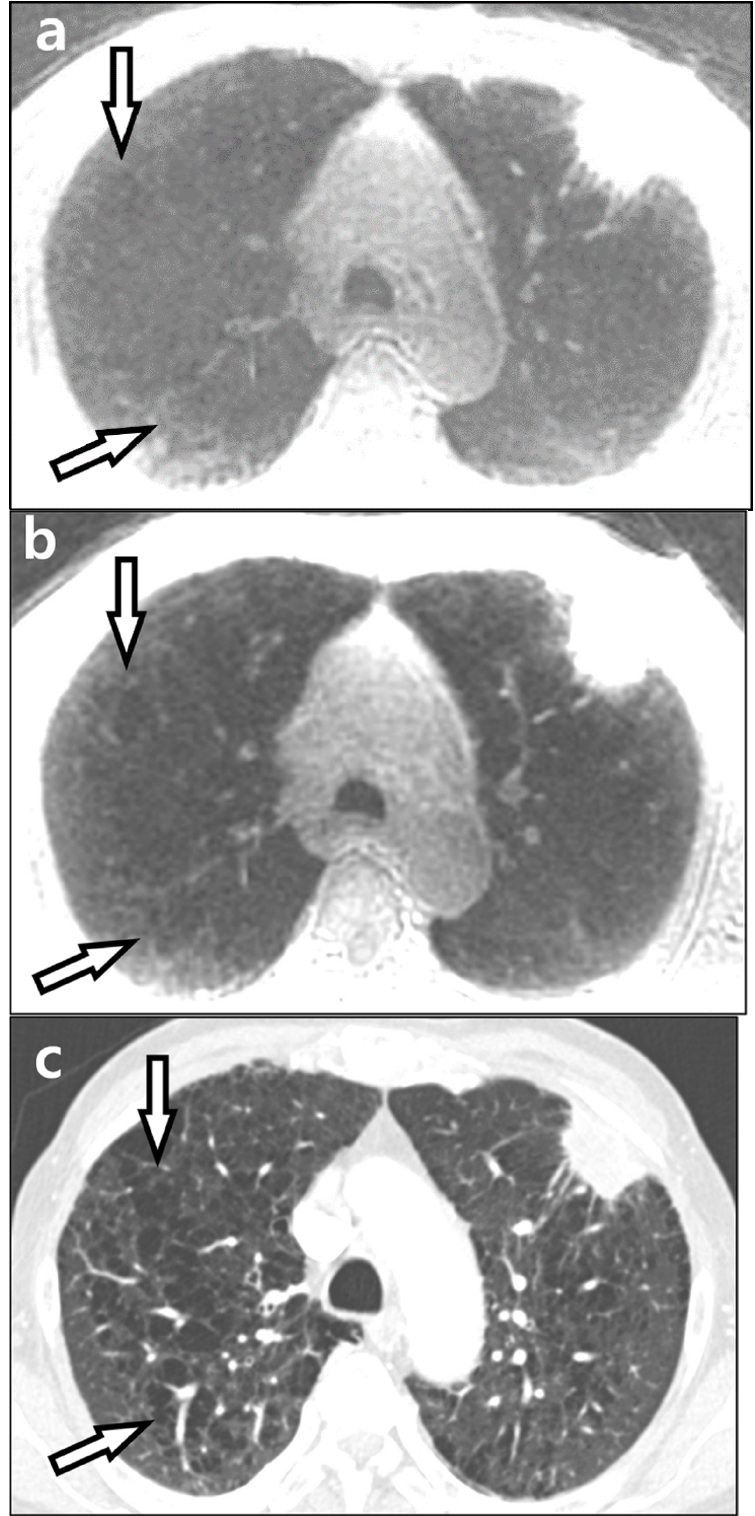
Figure 3. An 83-year-old male with lung cancer. A lobulated mass in the left upper lobe is well- defined in both ZTE-CAA ( a ) and ZTE-AIR ( b ). However, the presence of emphysema is more clearly defined in ZTE-AIR. CT image is presented for comparison ( c ). ZTE-CAA, zero echo time lung MR image using conventional anterior array coil; ZTE-AIR, zero echo time lung MR image using adaptive image receive coil.